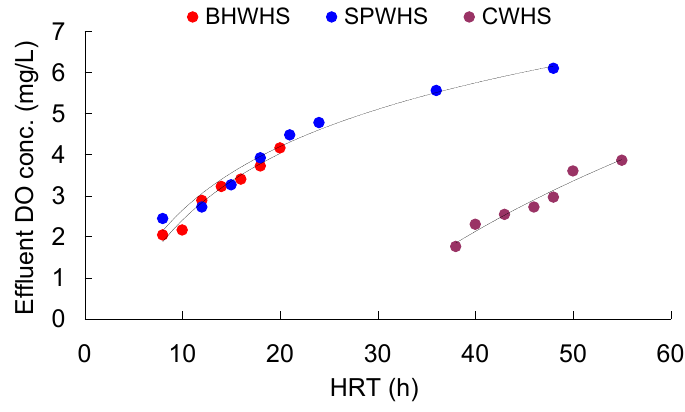
Figure 3. Mean DO values of the process effluent ( n =